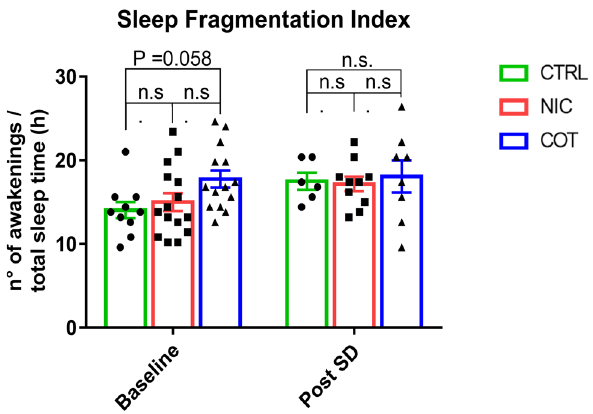
Figure 2. Sleep fragmentation index. Values of sleep fragmentation index calculated as the n° of awakenings/ total sleep time (in hours) during 48 h of baseline recordings and 18 h of recordings during recovery after sleep deprivation (SD) by gentle handling for 6 h. Values are shown for adult male mice perinatally exposed to nicotine (NIC, n = 15), cotinine (COT, n = 14) or just the vehicle (CTRL, n = 10). Values after sleep deprivation were calculated on 10 NIC, 8 COT and 6 CTRL mice. n.s., not